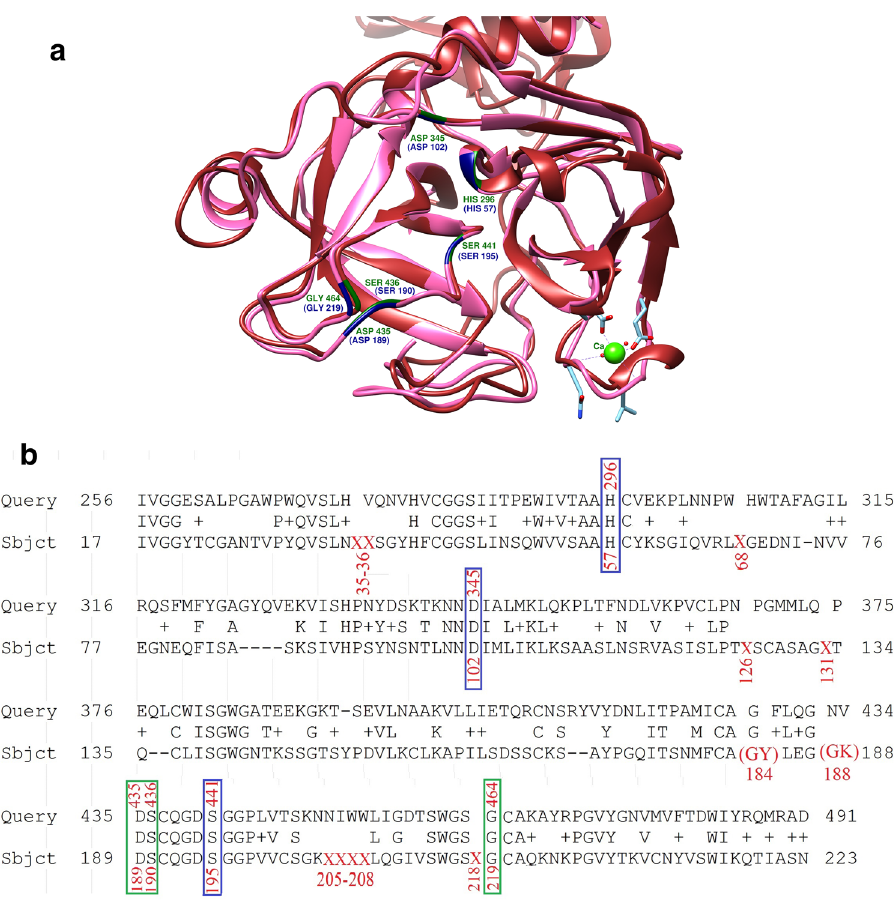
Figure 4. 3D structure and sequence alignment of TMPRSS2 against the Trypsin. ( a ) The 3D structure of TMPRSS2 is colored in brown and the key residue in dark-green, the 3D structure of Trypsin is in hot pink color and its key residue in navy-blue. This figure has been produced by the UCSF Chimera 1.14-linux_x86_64 (https ://www.cgl.ucsf.edu/chime ra/downl oad.html). ( b ) The pairwise alignment of NP_005647(TMPRSS2) with the 2AGE sequence of trypsin has been shown. The important matched residues have been put in rectangular (the catalytic triad in blue and important residue for binding in green). The missing residues in the PDB file have been shown by X and the double residues in one position put in